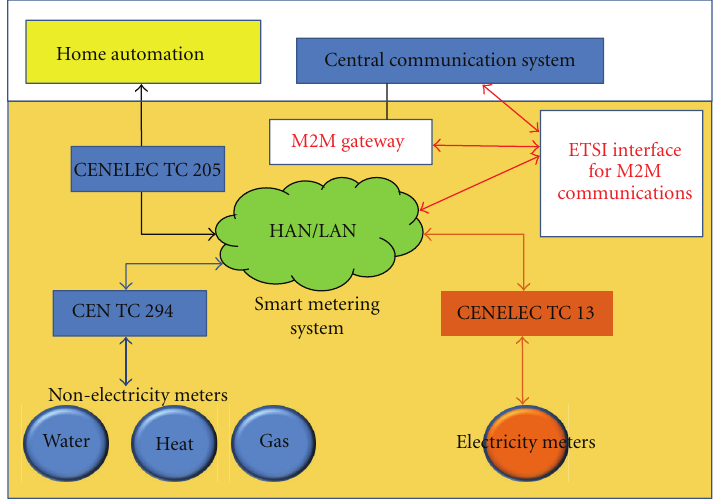
Figure 2: M441 responsibility split among